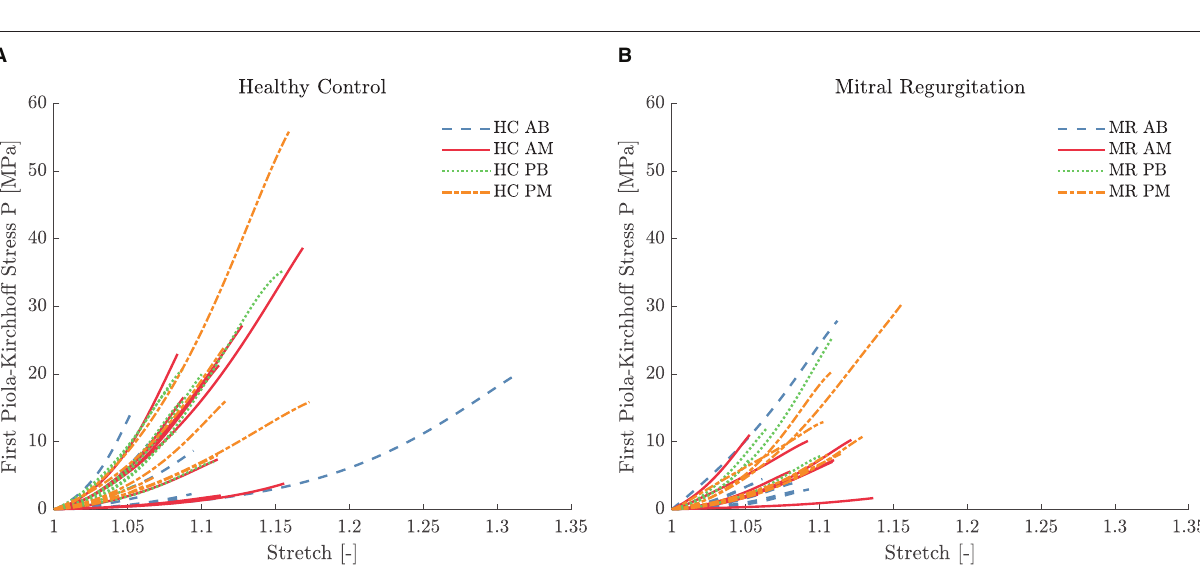
FIGURE 7 | First Piola-Kirchhoff stress versus stretch per chordal group for the (A) HC and (B) MR valves. The model stress was derived by parameter fitting to the third order Ogden constitutive model. The stretch range was defined based on the experimental data of the highest reached strain level for each sample.